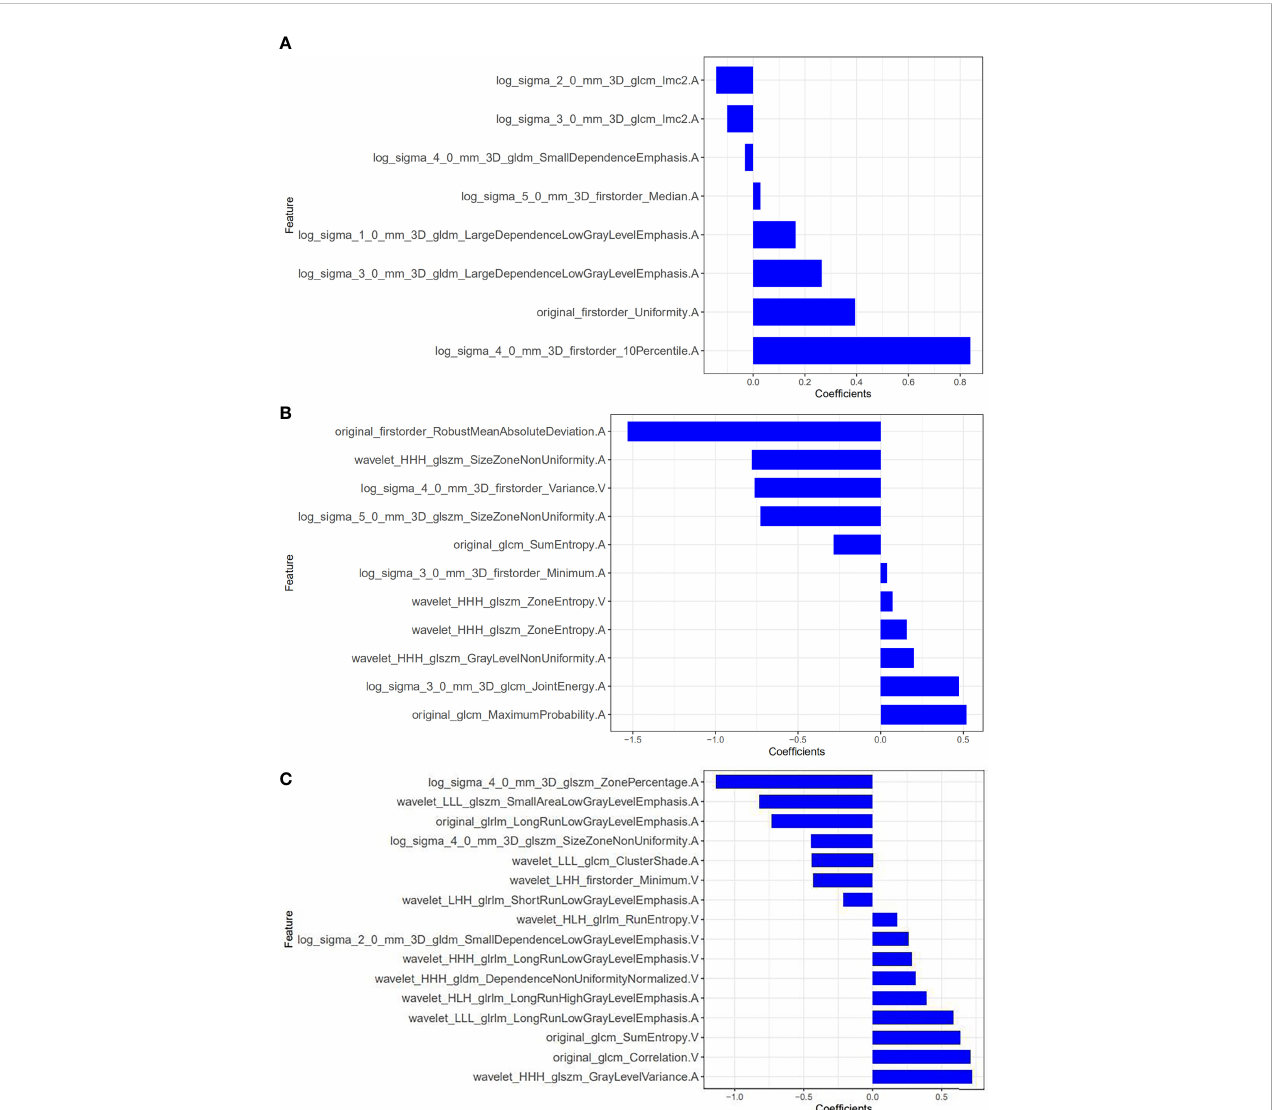
FIGURE 5 Radiomic features screened by models 1-3 and their weights. (A) model 1; (B) model 2; (C) model 3 (The letters A and V in the feature names indicate that the feature was extracted from the arterial phase and the venous phase,